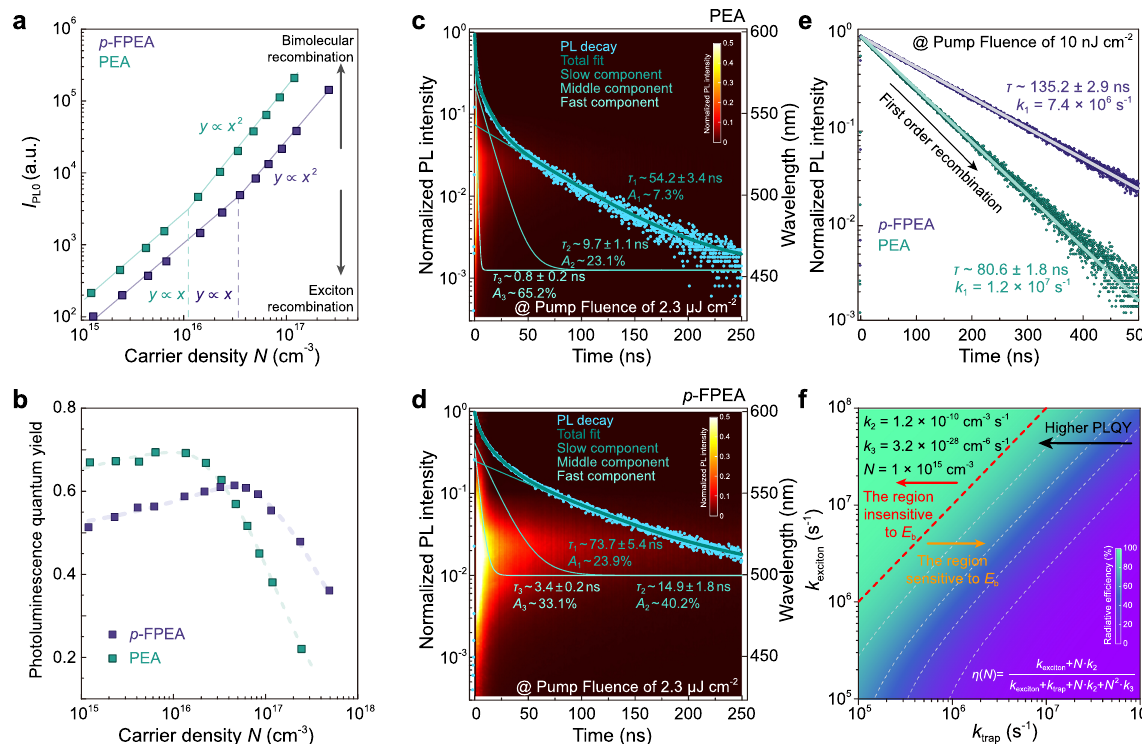
Fig. 2 Recombination dynamics of quasi-2D fi lms with different E b . a PL intensity at t = 0 ( I PL0 ) as a function of carrier density. b Film ’ s PLQYs as a function of carrier density for PEA and p -FPEA quasi-2D fi lms, respectively. Time- and wavelength-dependent photoluminescence (PL) mapping under a pump fl uence of 2.3 μ J cm − 2 for c PEA and d p -FPEA fi lms. e TRPL decay transients for PEA and p -FPEA perovskite fi lms under a low pump fl uence of 10 nJ cm − 2 . f Simulated radiative ef fi ciency as a function of k exciton and k trap for quasi-2D fi